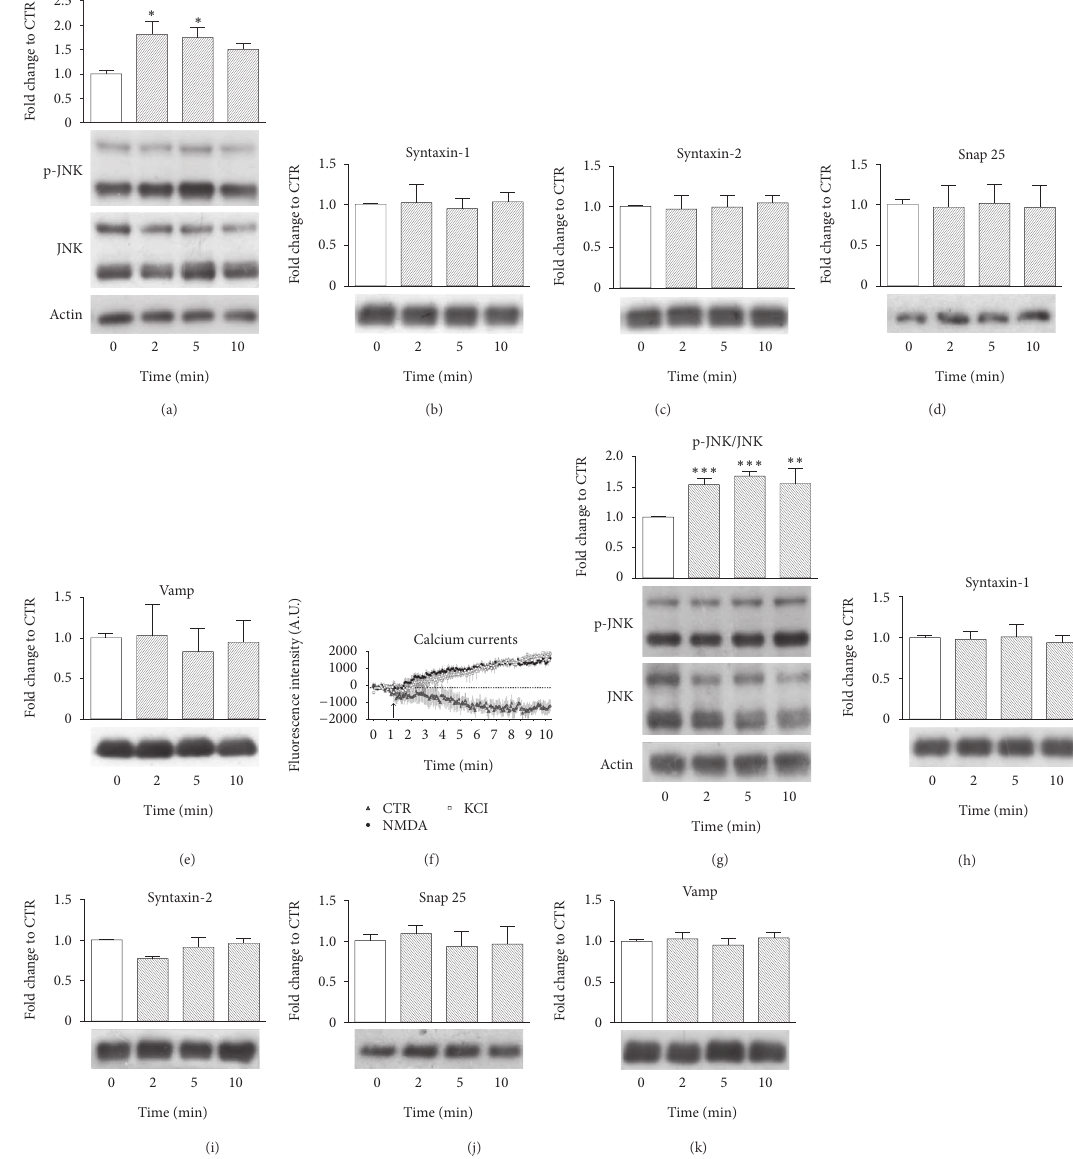
Figure 2: JNK is activated after pre-NMDARs stimulation in young mice and adult. (a–e) Western blotting and relative quantification of JNK activation (a), measured as p-JNK/JNK ratio, on p14 mice crude synaptosomes stimulated with NMDA 100 𝜇 M and glycine 1 𝜇 M for 2, 5, and 10 min. JNK activation significantly increases 2min after treatment ( ∗ 𝑝 < 0.05 ) and persists at 5 min ( ∗ 𝑝 < 0.05 ). Western blotting and relative quantification of presynaptic proteins Syntaxin-1 (b), Syntaxin-2 (c), Snap25 (d), and Vamp (e) extracted from p14 mice crude synaptosomes stimulated with NMDA 100 𝜇 M and glycine 1 𝜇 M for 2, 5, and 10min. Protein levels remain unchanged after treatment at the considered time-points. Actin was used as loading control (20 𝜇 g proteins loaded; 𝑁 = 5 ). One-way ANOVA, Dunnet’s post-hoc test. Data are showed as mean ± S.E.M. (f) Calcium currents, measured with calcium sensible fluorophore Fluo4, on crude synaptosomes treated with NMDA 100 𝜇 M and glycine 1 𝜇 M or with KCl 50 mM. Fluorescence was recorded with a spectrophotometric approach for 7 min, with NMDA + Gly or KCl injection at 45 sec. After both injections there was a significant increase in calcium levels starting from 45 sec after stimulation (each experimental group 𝑁 = 5 ). One-way ANOVA, Dunnet’s post hoc test. Data are shown as mean ± S.E.M. (g–k) Western blotting and relative quantification of JNK activation (g), measured as p-JNK/JNK ratio on adult mice crude synaptosomes stimulated with NMDA 100 𝜇 M and glycine 1 𝜇 M for 2, 5, and 10min. JNK activation increases 2min after treatment ( ∗∗∗ 𝑝 < 0.001 ) and persists at 5min ( ∗∗∗ 𝑝 < 0.01 ) and at 10min ( ∗∗ 𝑝 < 0.01 ). Western blotting and relative quantification of presynaptic proteins Syntaxin-1 (h), Syntaxin-2 (i), Snap25 (j), and Vamp (k) extracted from adult mice crude synaptosomes stimulated with NMDA 100 𝜇 M and glycine 1 𝜇 M for 2, 5, and 10min. Protein levels remained unchanged after treatment for all three time-points. Actin was used as loading control (20 𝜇 g proteins loaded; 𝑁 = 4 ). One-way ANOVA, Dunnet’s post hoc test. Data are shown as mean ±